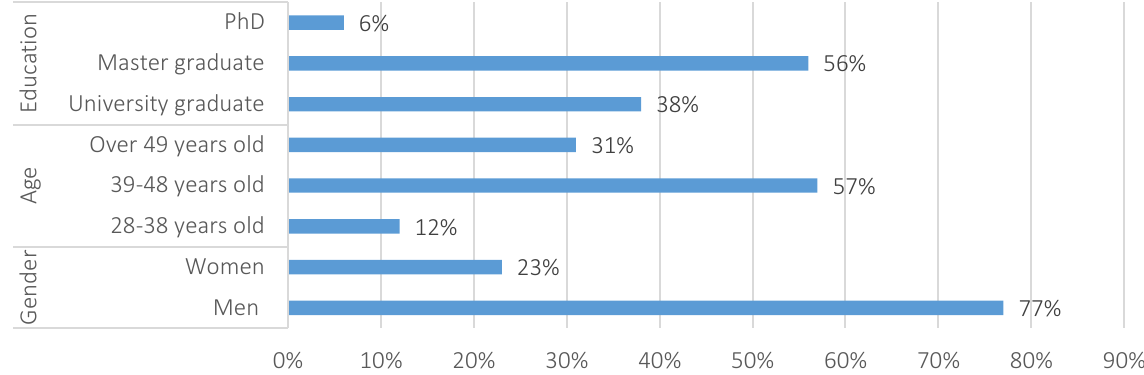
Figure 1. Demographic characteristics of respondents